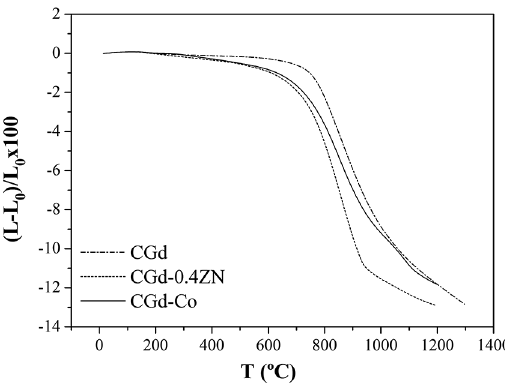
Figure 1: Shrinkage profiles obtained for undoped, zinc, and cobalt-doped